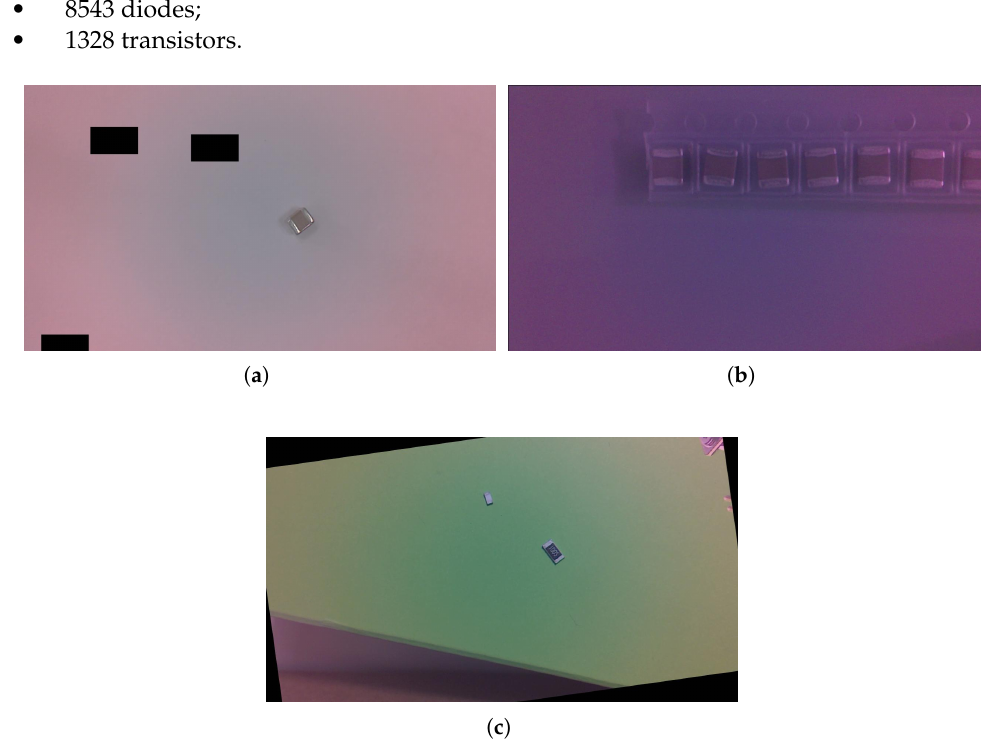
Figure 5. Pre-processing techniques used for dataset augmentation. ( a ) Random cut-outs, ( b ) color augmentation; ( c ) random rotation between − 15° and +15°.